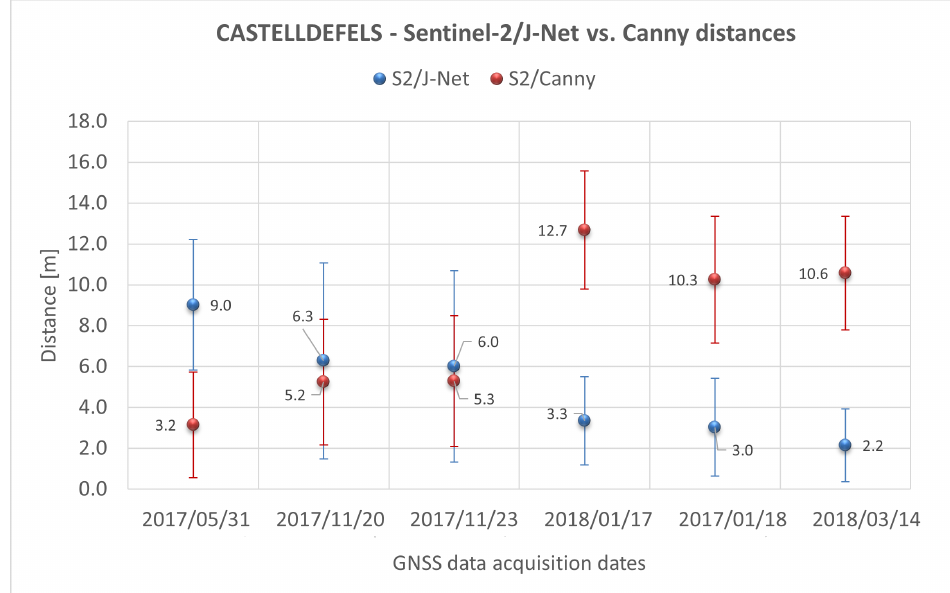
Figure A1. Comparison between the mean distance and standard deviation for each date on Sentinel-2 imagery considering J-Net Dynamic and Canny algorithms in